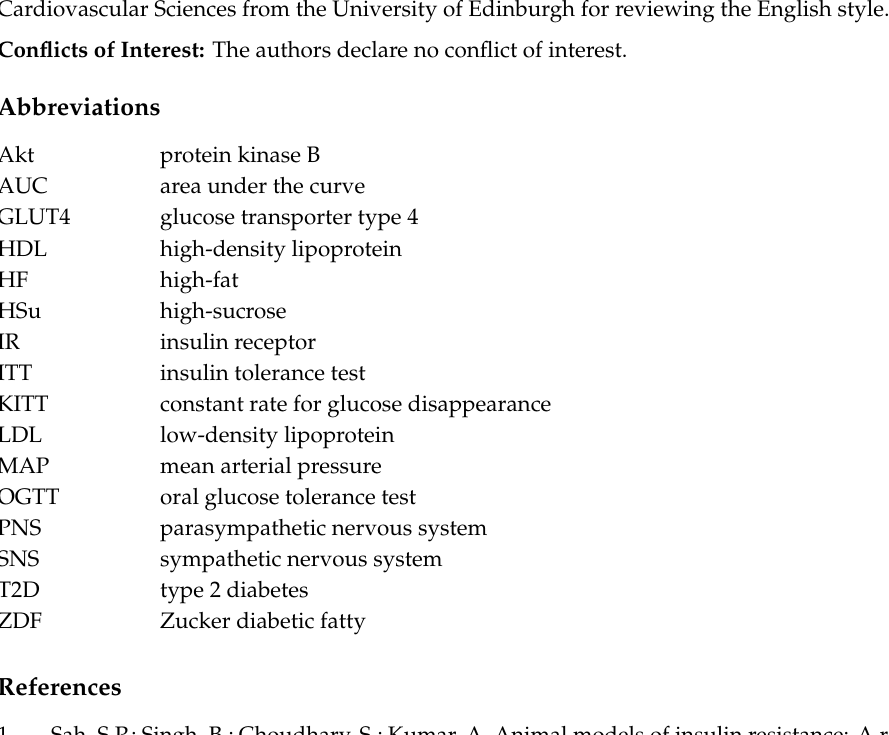
Figure S1: Membranes of the Western blots performed to study the alterations in the expression of proteins involved in insulin signaling in the adipose tissue, in animal models of obesity and type 2 diabetes, Table S1: Composition of 45% lipid-rich diet, Table S2: Composition of 60% lipid-rich diet, Table S3: Composition of Purina 5008, Table S4: Composition of Standard